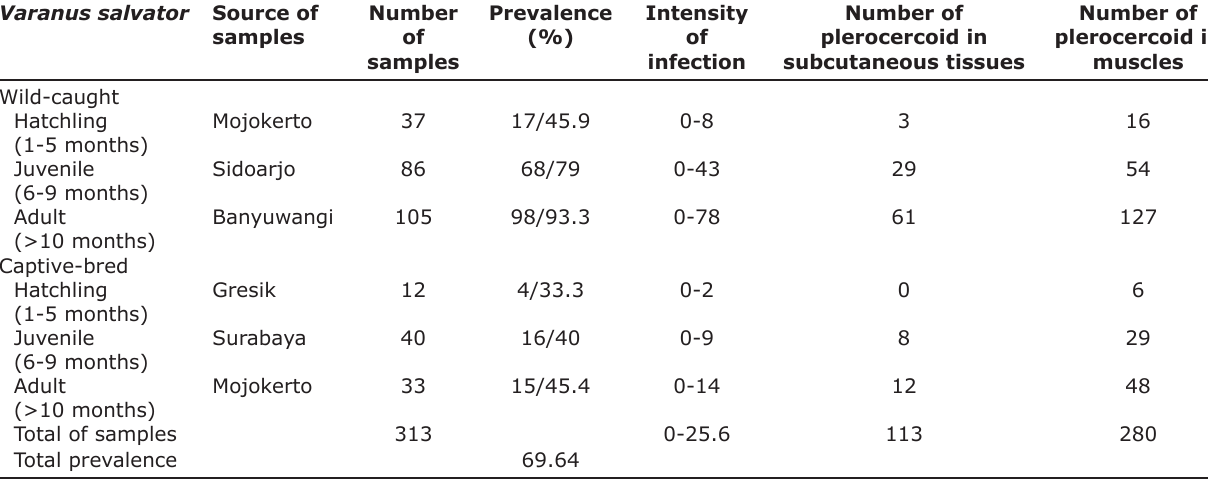
Table-1: Essential information regarding source, prevalence, intensity, and locations of plerocercoid infection of the 313 wild-caught and captive-bred monitor lizard samples from reptile markets in East Java Province, Indonesia. Varanus salvator Source of